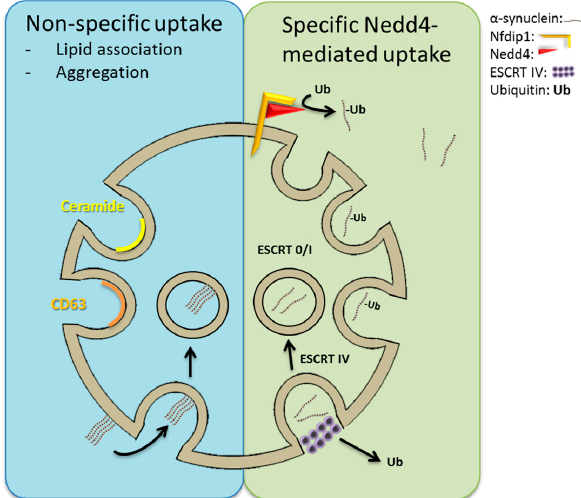
Figure 2. Import of cytosolic α -synuclein into intraluminal vesicles of multivesicular bodies and late endosomes. ( Right ) Nfdip1 recruits the E3 ubiquitin ligase Nedd4 to the limiting membrane of multivesicular bodies and late endosomes. Neuronal precursor cell-expressed developmentally downregulated 4 (Nedd4) ubiquitinates (Ub) α -synuclein, which thereby becomes a substrate of the